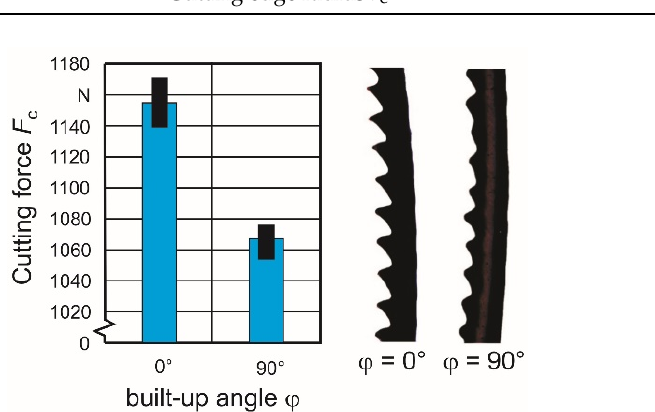
Figure 3. Experimental determined cutting force F c and chip shape depending on material orienta-